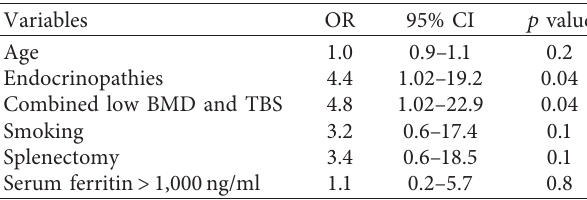
Table 3: Multivariate analysis of risk factors for vertebral